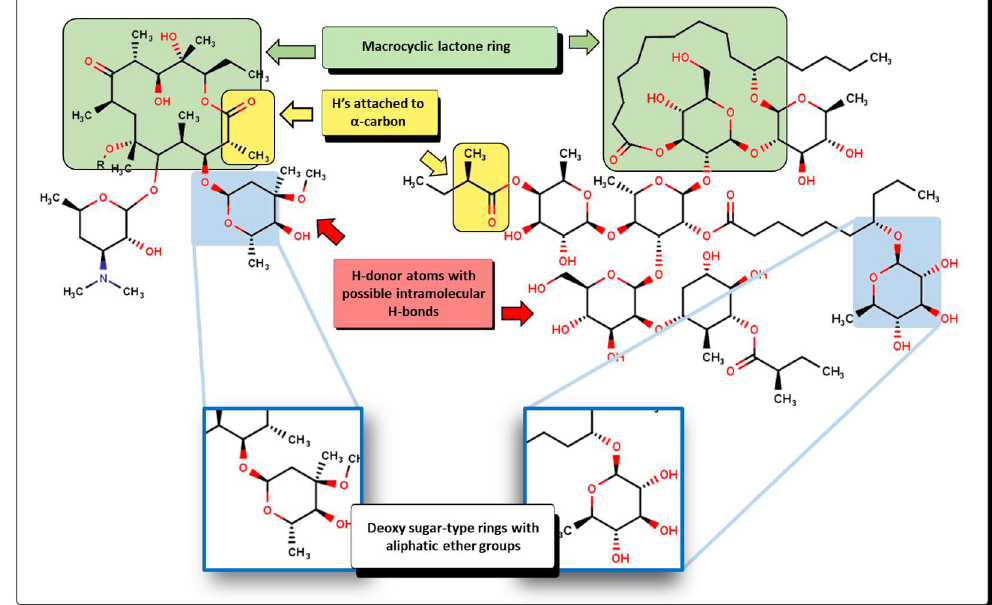
Figure 19. Structural comparison between a macrolide (clarithromycin) and compound 63 , where arrows indicate the descriptors that are shared.